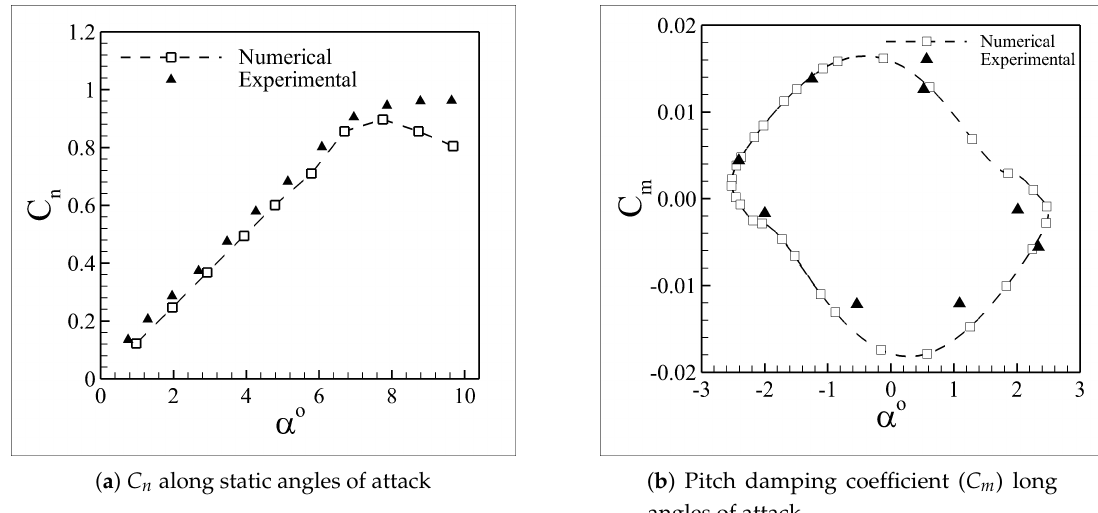
Figure 6. Comparison of stability derivatives with experimental